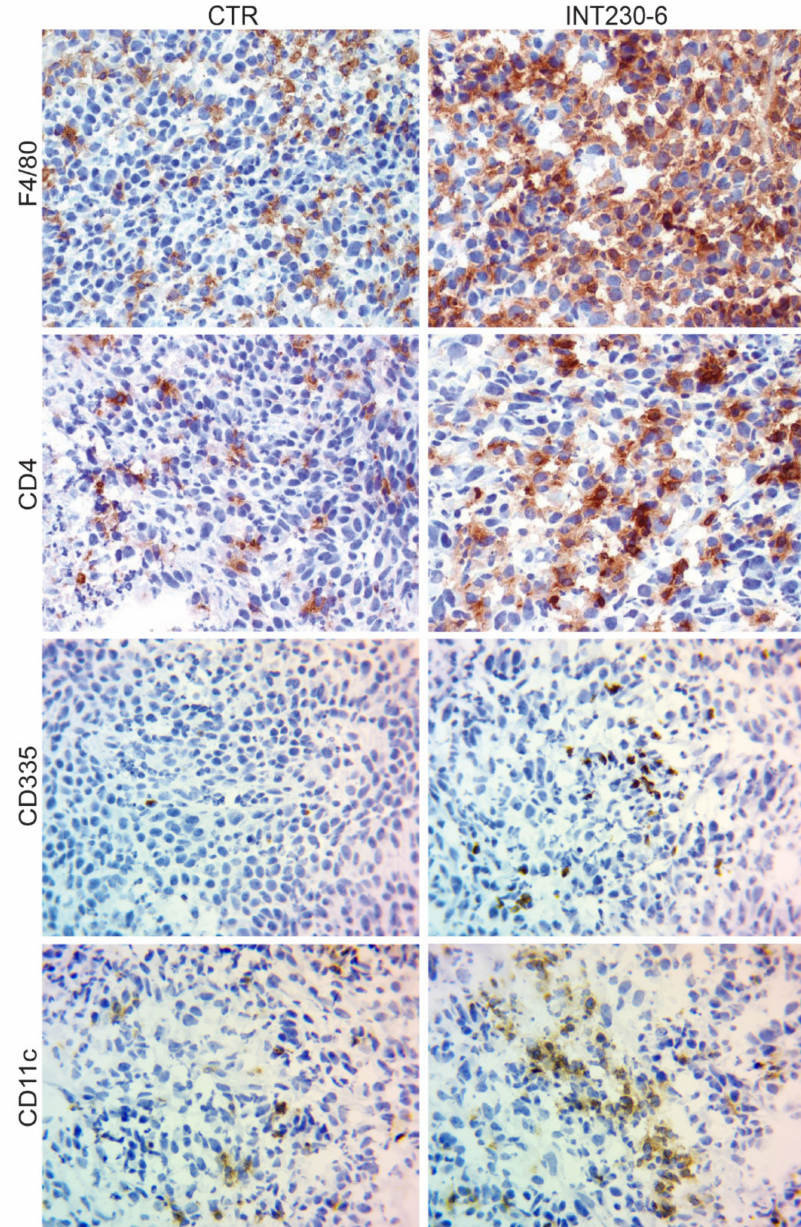
Figure 5. IHC analysis of Colon-26 tumors untreated and INT230-6-treated tumors ~10 days post